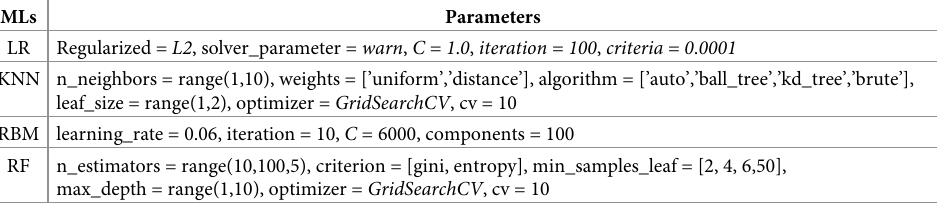
Table 1. Parameters of the four machine learning models used in prediction